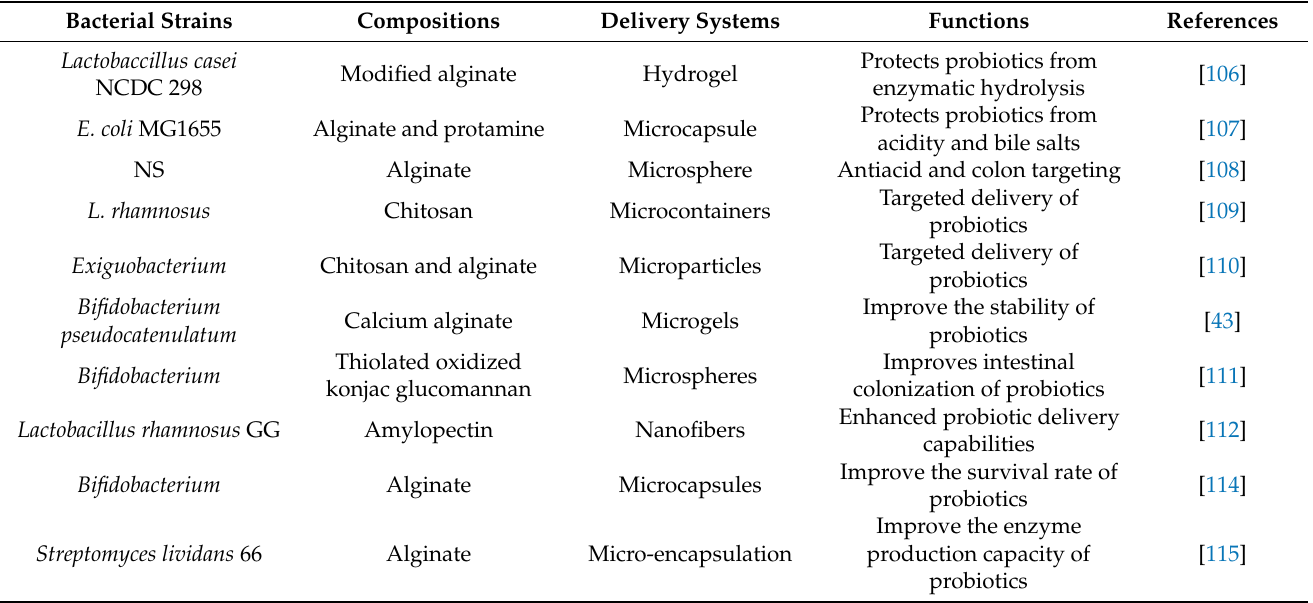
Table 2. Delivery system of